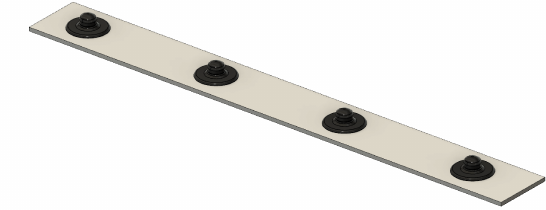
Figure 7. Armband design: the 8-electrode armband consists of two of the illustrated structures.